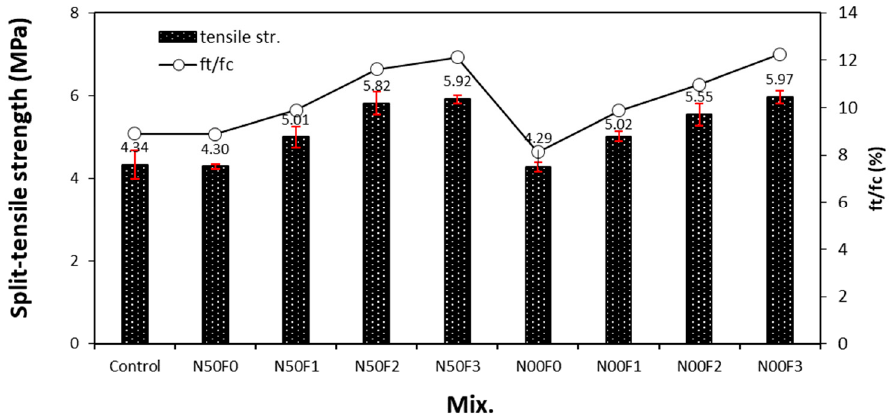
Figure 7. Tensile strengths of different mixture samples.